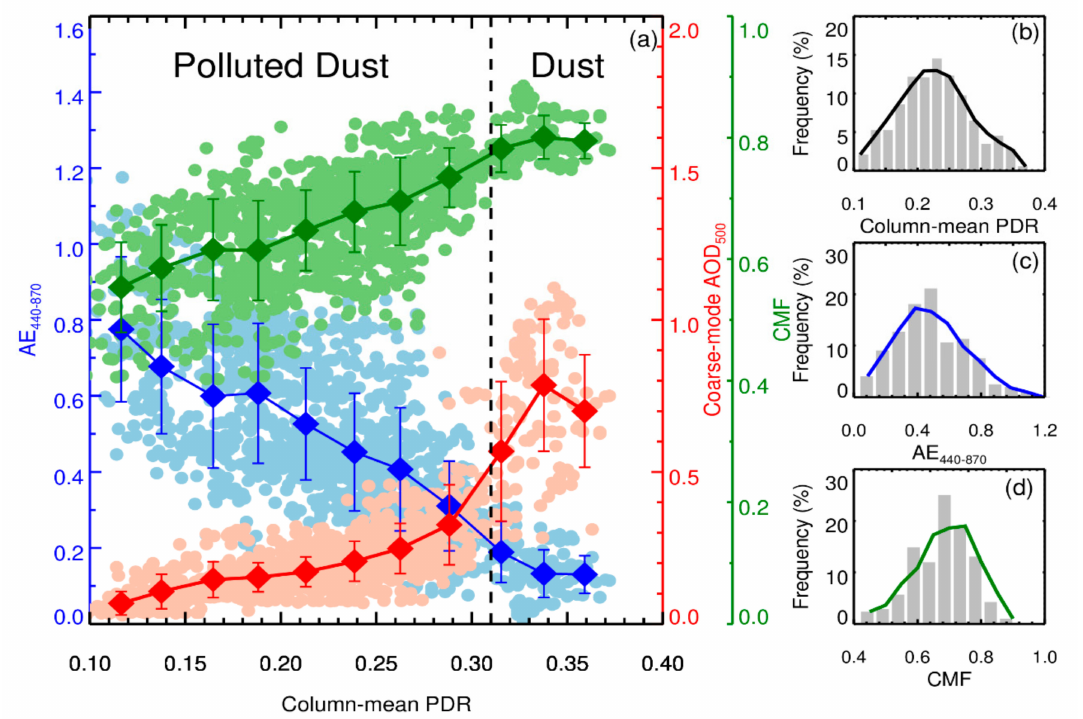
Figure 2. ( a ) The relationship between AE 440–870 (blue), coarse-mode AOD 500 (red), coarse-mode fraction (CMF; green) and column-mean PDR in the Northwest China. The diamonds and whiskers represent the average and SD of AE 440–870 , coarse-mode AOD 500, and CMF in each PDR bin. The vertical dashed lines denote the turning point between the dust and polluted dust according to the PDR threshold of Asian dust (0.31). The frequency distribution of ( b ) PDR, ( c ) AE 440–870 , and ( d ) CMF are also in the right panel, respectively (total samples: